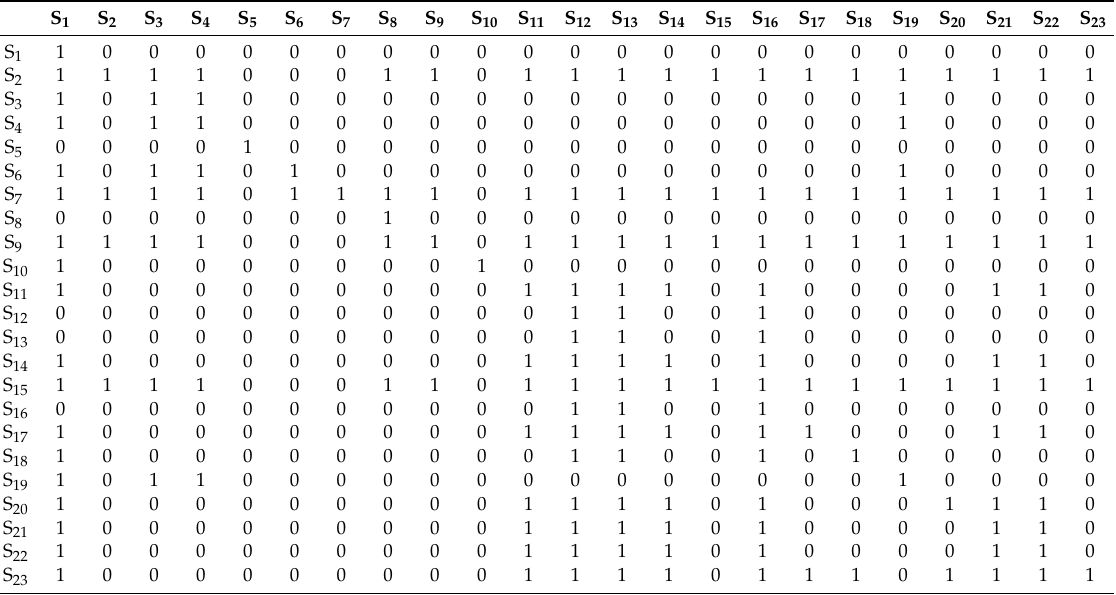
Table 3. The accessibility matrix of super-gentrification dynamic